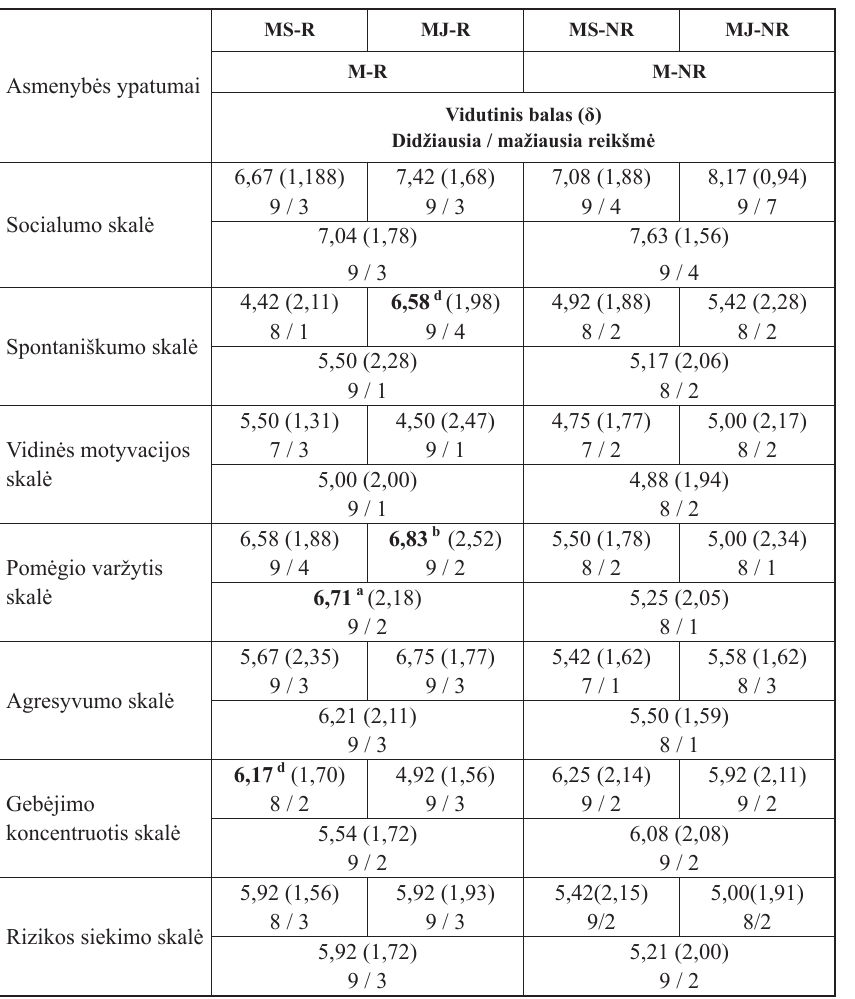
Pastaba. Žym ė jimai — kaip 1